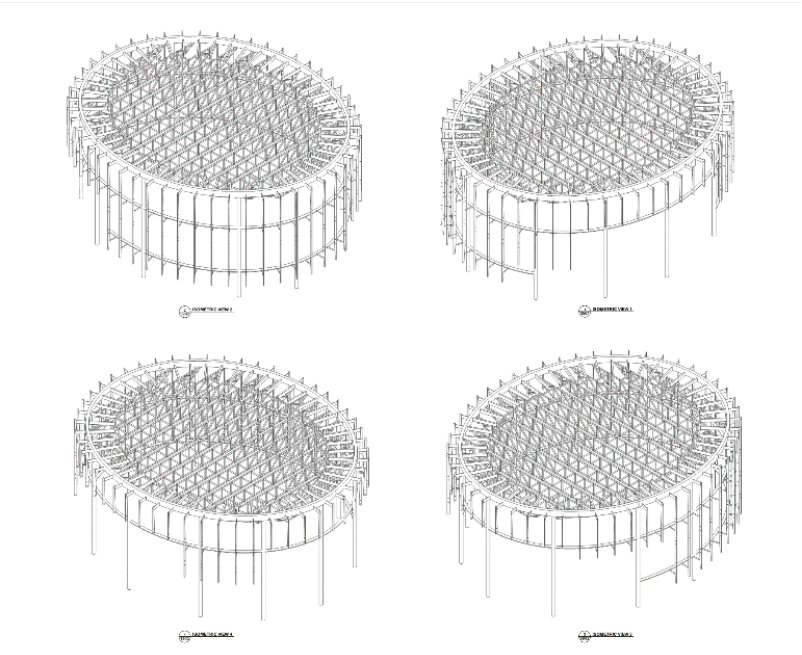
Fig. 1 Overall Rotunda geometry.